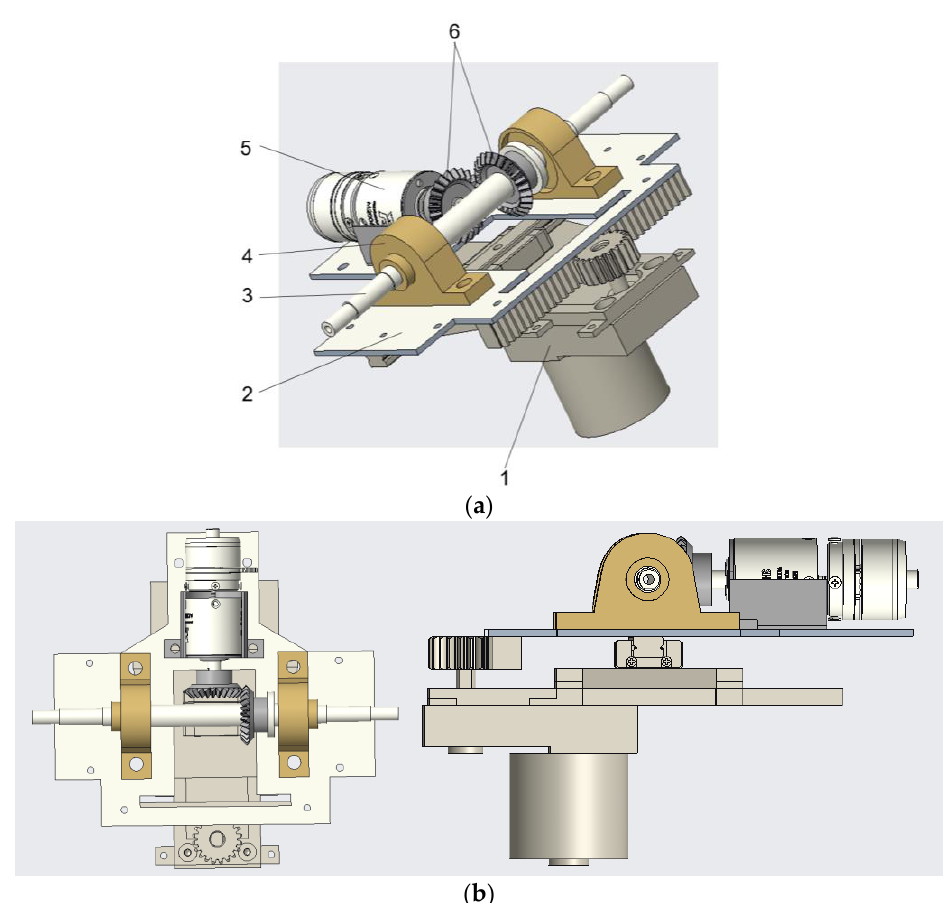
Figure 2. ( a ) The structure chart of the rolling module , 1-counterweight, 2-sheet metal, 3-major shaft, 4-bearing, 5-motor, and 6-bevel gear set; ( b ) Front view and top view of the jumping driver part. By driving the motor to change the deflection angle of the counterweight in the motion plane, the forward or backward rolling motion was realized. The simplified model is shown in Figure 3a, and the schematic diagram of the counterweight position in rolling motion is shown in Figure 3b. Point A is the center of rotation of the pendulum and point B is the center of gravity of the simple pendulum.